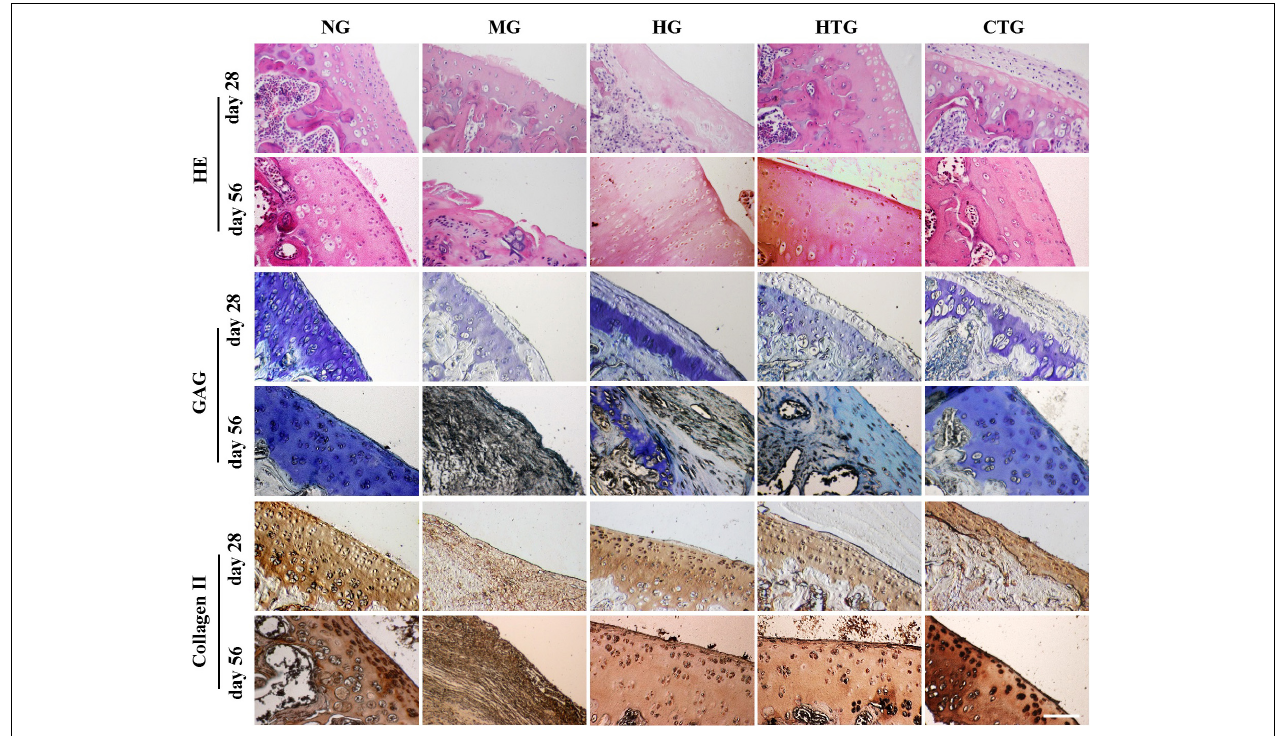
FIGURE 5 | Pathological changes of knee joint cartilage repair of rat OA models after treatment. Top: HE, Middle: Tolune blue for GAG, Bottom: Immunohistological staining for Collagen II. NG, LG-DMEM; MG, Model group; HG, 0.05 mg/mL HA; HTG, hAMSCs 1 × 10 6 ; CTG, HA (0.05 mg/mL) + hAMSCs (1 × 10 6 ). Scale bar: 50 µ m. This figure shows the representative tissue sections of each group containing six rats.